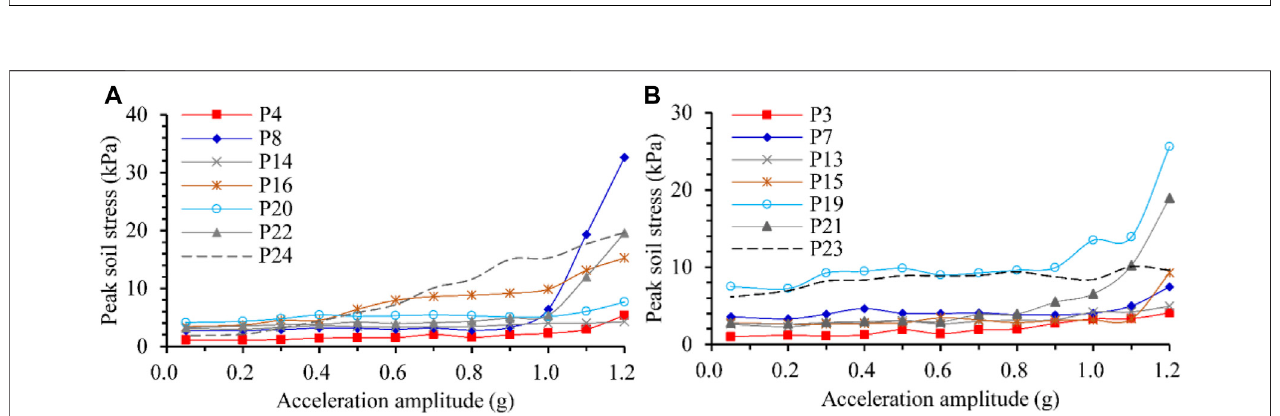
FIGURE 17 | The peak stresses in soil versus the excitation acceleration. (A) Stresses in the x direction and (B) stresses in the z direction.